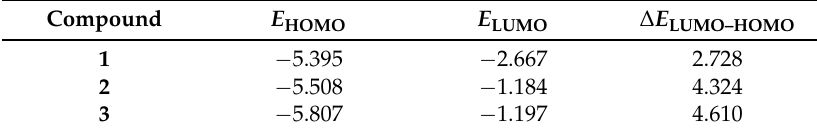
Table 7. Frontier molecular orbital energies of 1 , 2 and 3 (eV).